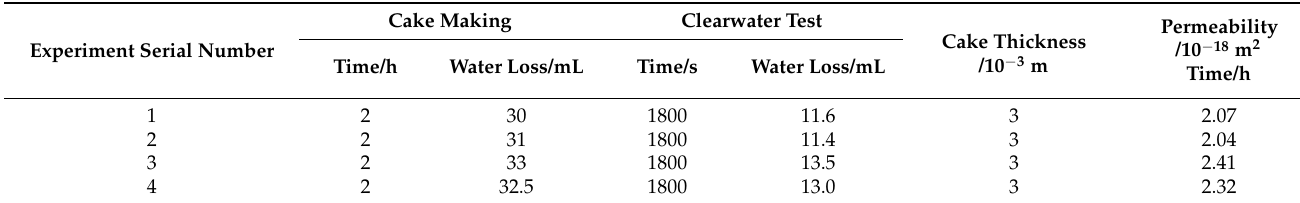
Table 1. Experimental results of common barite-based slurry artificial mud cake.